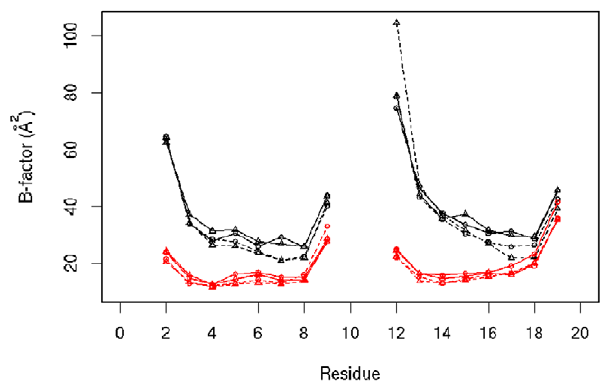
Figure 2. Theoretical B-factors for the four systems studied calculated from the simulations. Black lines , B-DNA simulations; red lines , Z-DNA simulations; solid lines , unmethylated DNA; dahsed lines , methylated DNA; circles and tirangles , independent simulation results for each system. Terminal bases not included in the calculatieon. Bases 11 to 20 form the complementary strand.